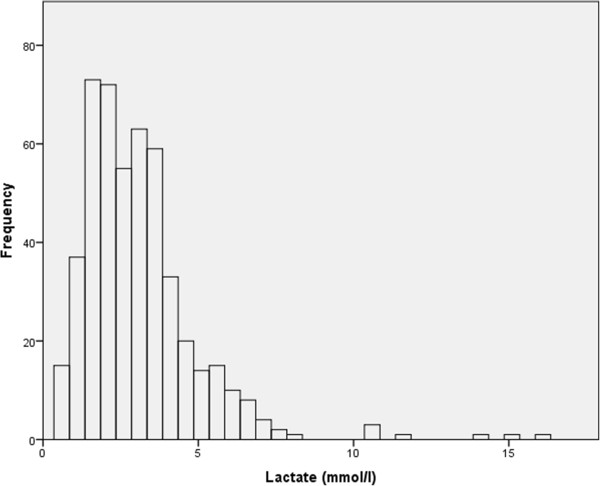
Distribution of arterial lactate concentration in 488 patients at the end of liver resection.